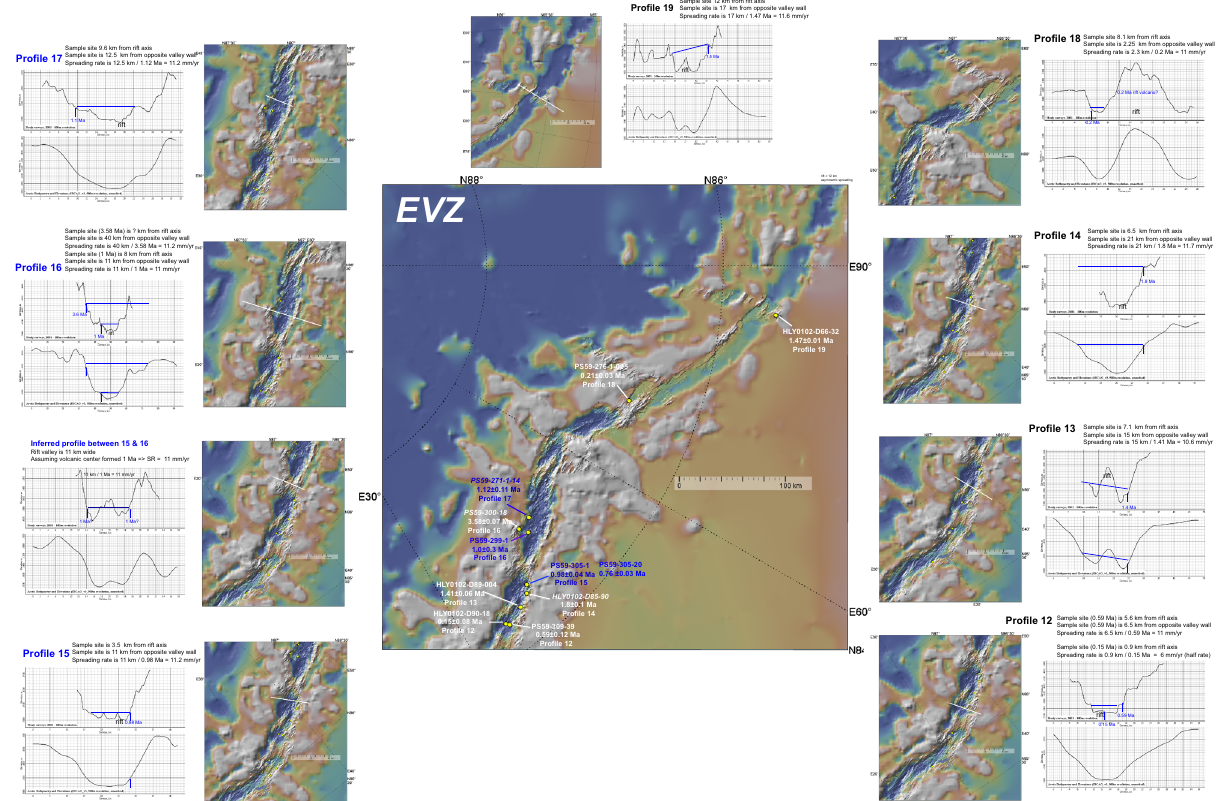
Fig. 4 Age-distance pro fi les in the EVZ. Blue text is for samples yielding coeval ~1 Ma ages and matching spreading rate from opposite fl anks the southern (P15) and northern (P16 & P17) fl anks of the EVZ. These pro fi les bound a magmatic centre in the rift valley. A similar spreading rate can be inferred from this volcanism assuming that P15 – P17 samples are from the same event. The process of successive cycles of volcanism and rifting discussed in the text is illustrated by P18 marking the early stage of dismemberment of a 0.2 Ma large axial ridge-like volcano fi lling the rift valley and P19 crossing an older, already dismembered 1.5 Ma axial volcano. Other details as in Fig. 2.